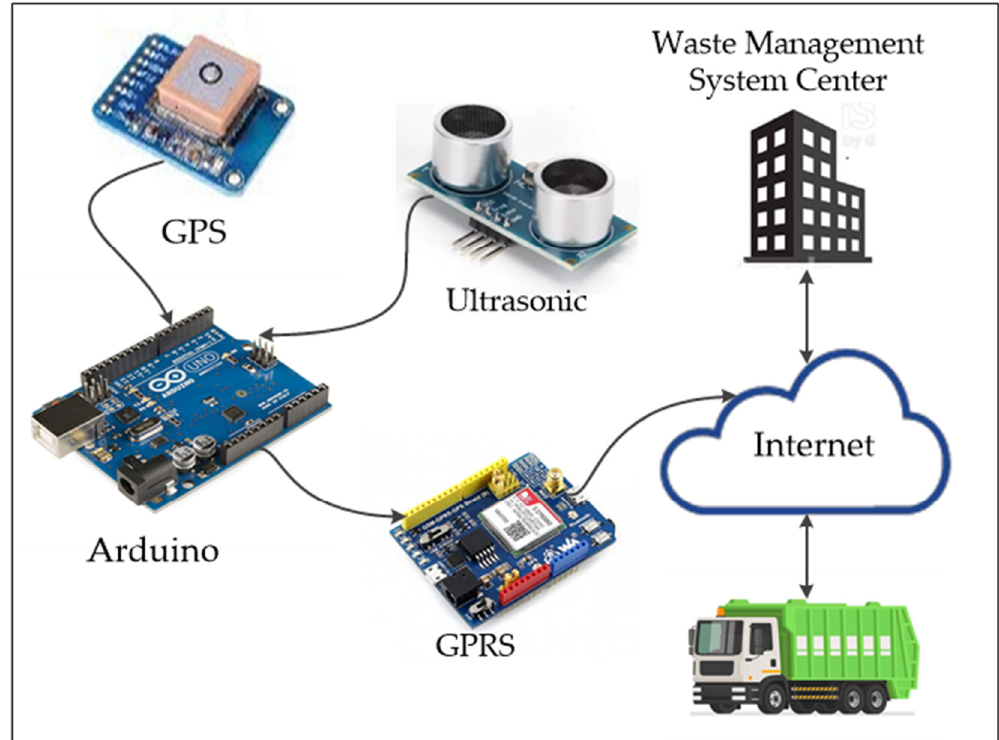
Figure 10. Integrated technology devices/applications.